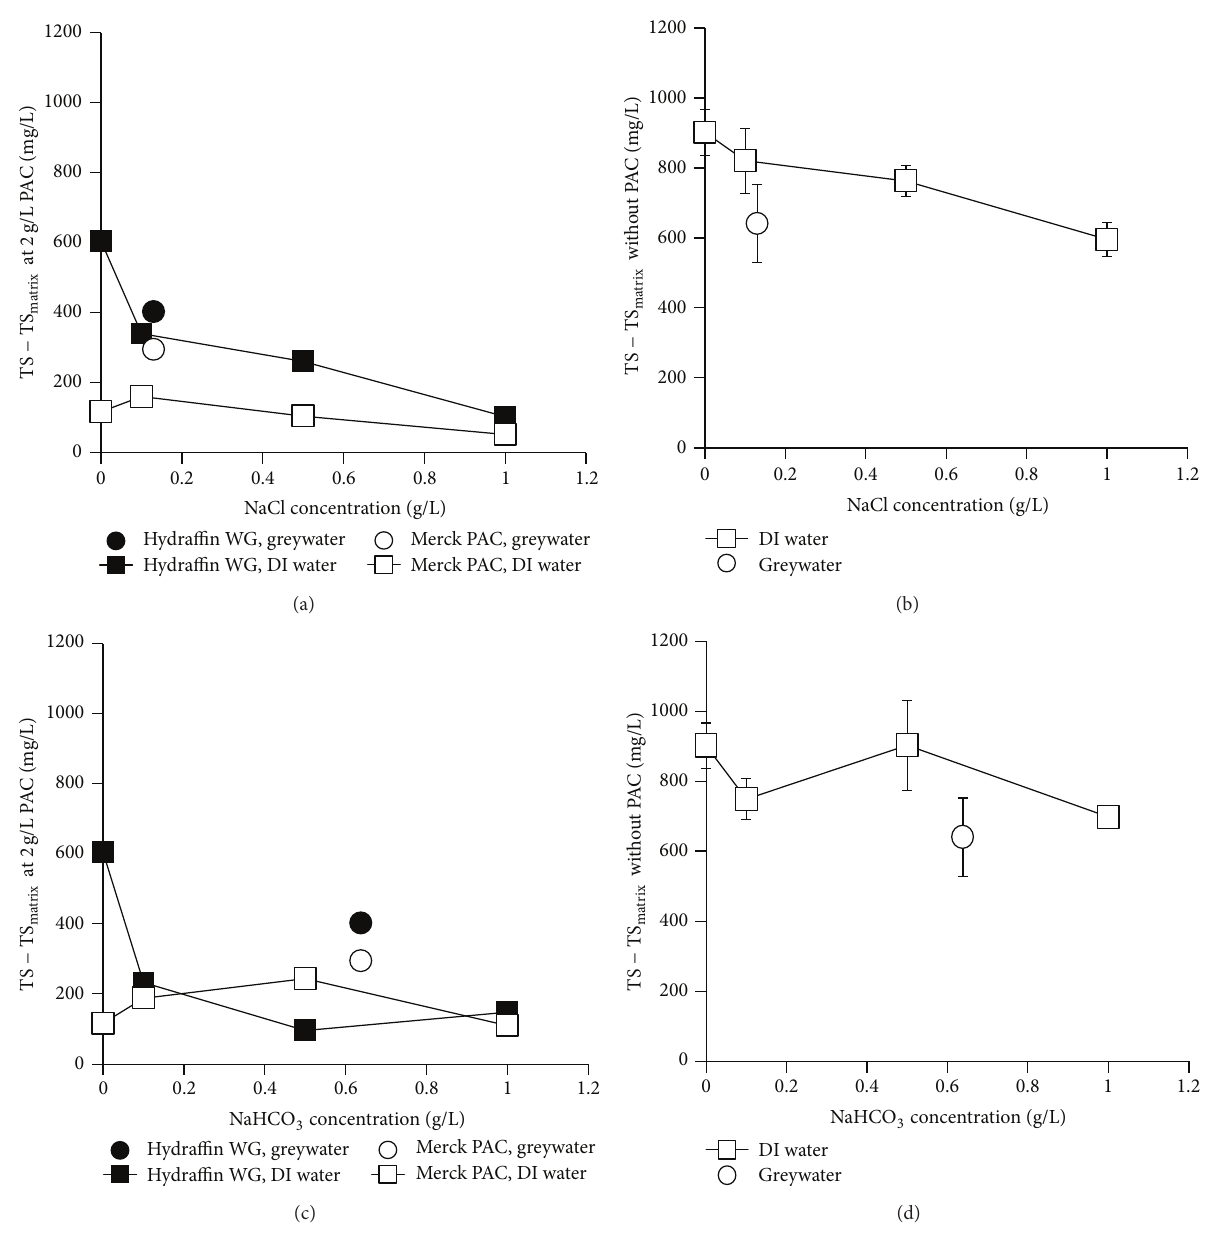
Figure 7: Total solids concentrations (corrected for TS concentrations of the matrices) in 1g/L TiO 2 suspensions containing 2 g/L PAC ((a), (c)) and in 1 g/L TiO 2 suspensions without any PAC ((b), (d)) at different NaCl ((a), (b)) and NaHCO 3 concentrations ((c), (d)) subsequent to vacuum filtration over spunbond polypropylene